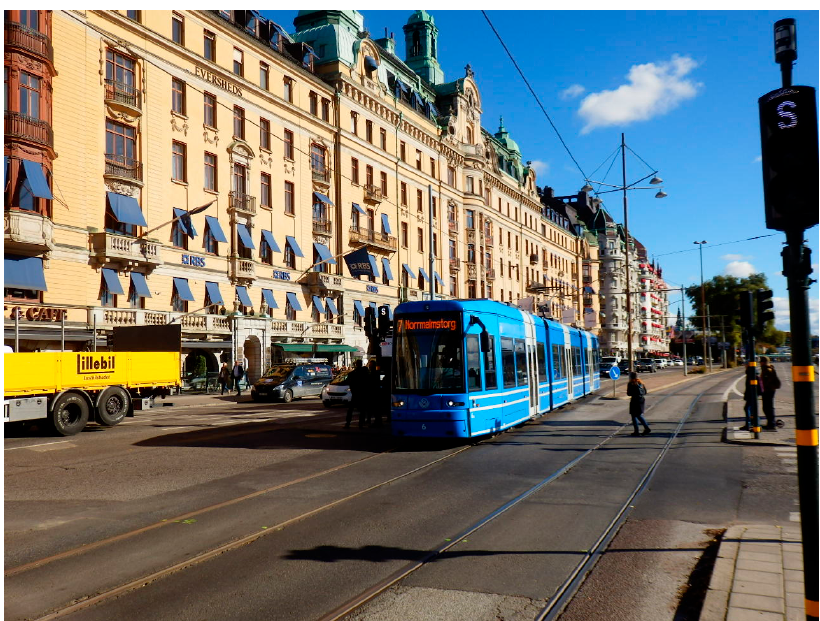
Figure 26. Stockholm’s old, dense, mixed use inner city based on tunnelbana, surface trams, walking, and cycling. Source: Jeffrey